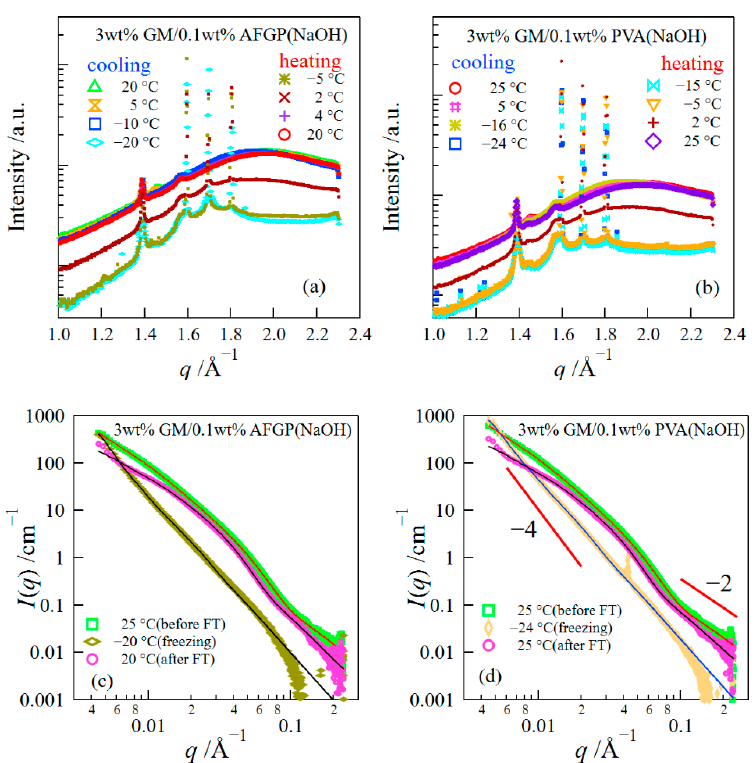
Figure 8. The compressive stress at different strains ( a ) and WAXS curves ( b ) for the freeze-thawed GM/AFGP and GM/PVA gels.